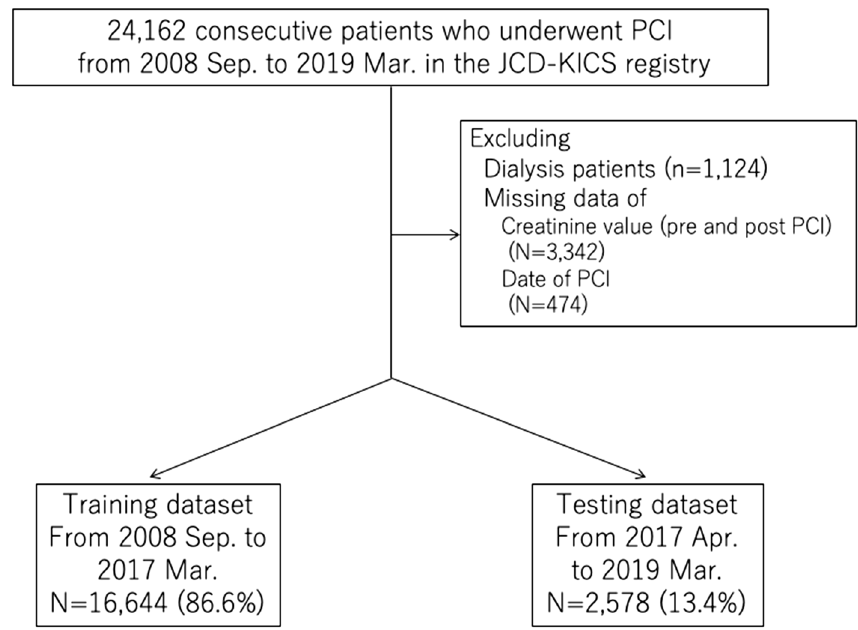
Figure 1. Patients’ flow chart. PCI: percutaneous coronary intervention, JCD-KiCS: Japanese Cardiovascular Database-Keio Inter-hospital Cardiovascular